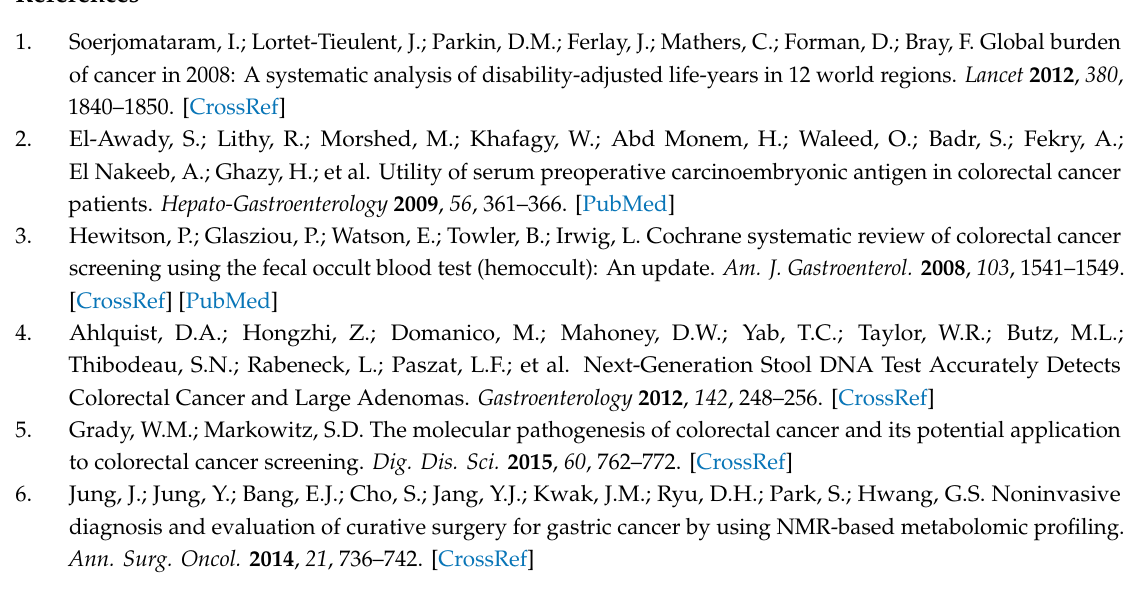
Figure S1: Principal Component Analyses (PCA) scores plot of 1H-NMR spectra of urine samples: C (full circle) and CRC (open circle) subjects. Two outliers are indicated with arrows. Figure S2: Hotelling’s T2 versus DModX plot: C (full circle) and CRC (open circle) subjects. Table S1: Proton chemical shifts of the metabolites identified in the 500 MHz 1H-NMR spectra of urine